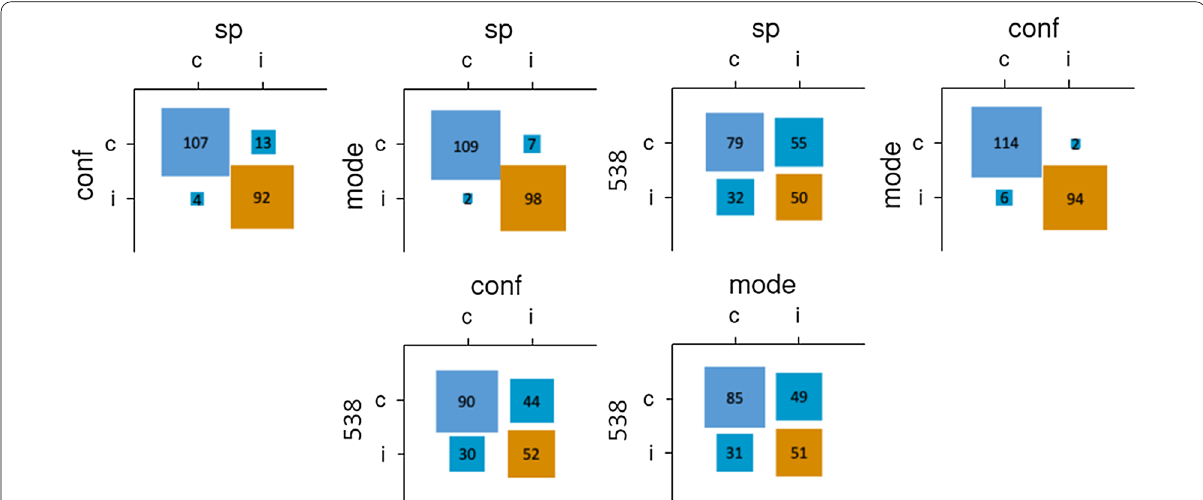
Fig. 1 Relationships between pairs of prediction methods for Study 1 (total sample). Note sp mode democratic; 538 Fivethirtyeight.com. Correct predictions are labeled as “c,” and incorrect predictions are labeled as “i,” with the top-left = = square indicating correct predictions from both methods, the bottom-right square indicating incorrect predictions from both methods, the bottom-left square indicating correct predictions from the left-labeled method but not the top-labeled method, and the top-right square indicating correct predictions from the top-labeled method but not the left-labeled method